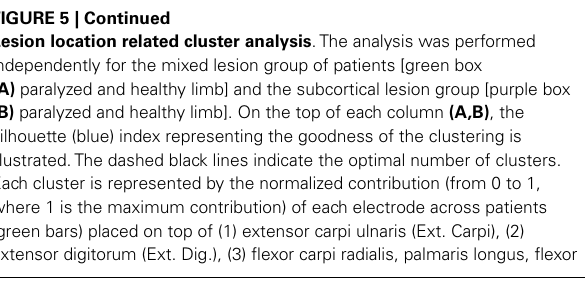
mergingleadtomorereducedhandfunctionality(hFMA)( n = 33, r = − 0.37, p = 0.033)( Figure4B